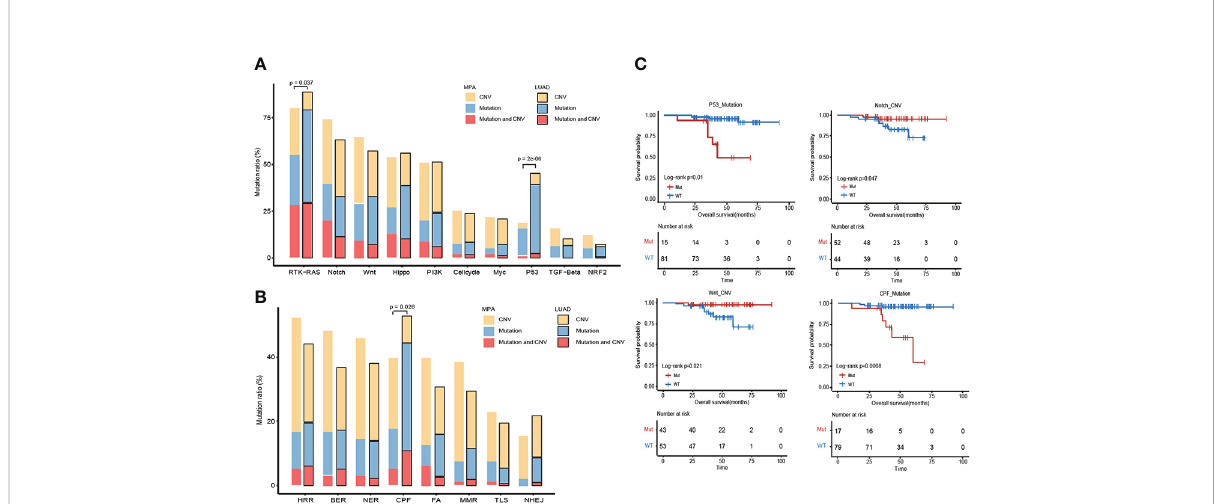
FIGURE 5 Comparison of the alteration frequency of genes in pathways across MPA and LUAD. (A) , Comparison of the alteration frequency of genes in ten hallmark pathways across the two cohorts. The yellow part point to the proportion of CNV only, the blue part is the proportion of only mutation, and the red part is the proportion of samples where CNV and mutation occur. The p -value marked on the column represents a fi sher test result of samples with and without mutations in MPA and LUAD in this pathway. (B) , Comparison of the enrichment of mutant genes in 8 DDR pathways in MPA and LUAD. The yellow part indicates that only one proportion of CNV occurs, the blue part is the proportion of only mutations, and the red part is the proportion of samples that have both CNV and mutation. The p -value marked on the column represents a fi sher test result of samples with and without mutations in MPA and LUAD in this pathway. (C) , Survival analysis results between mutant and wild type in 18 pathways. Only show the results of pathways with signi fi cant differences, and perform different analyses on CNV and mutation